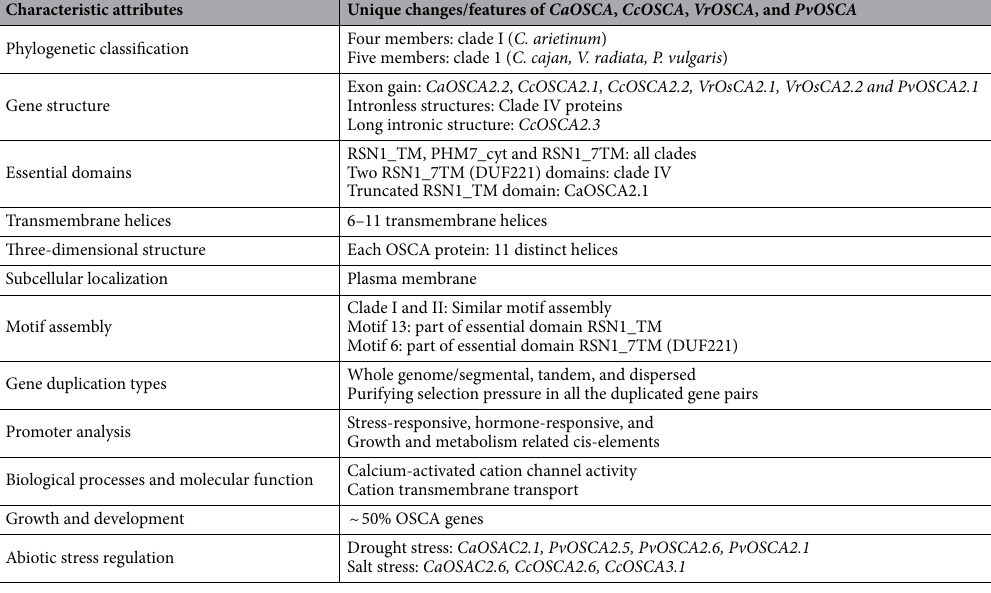
Table 1. Unique changes in the OSCA gene family in four legumes viz C. arietinum, C. cajan, V. radiata, P. vulgaris